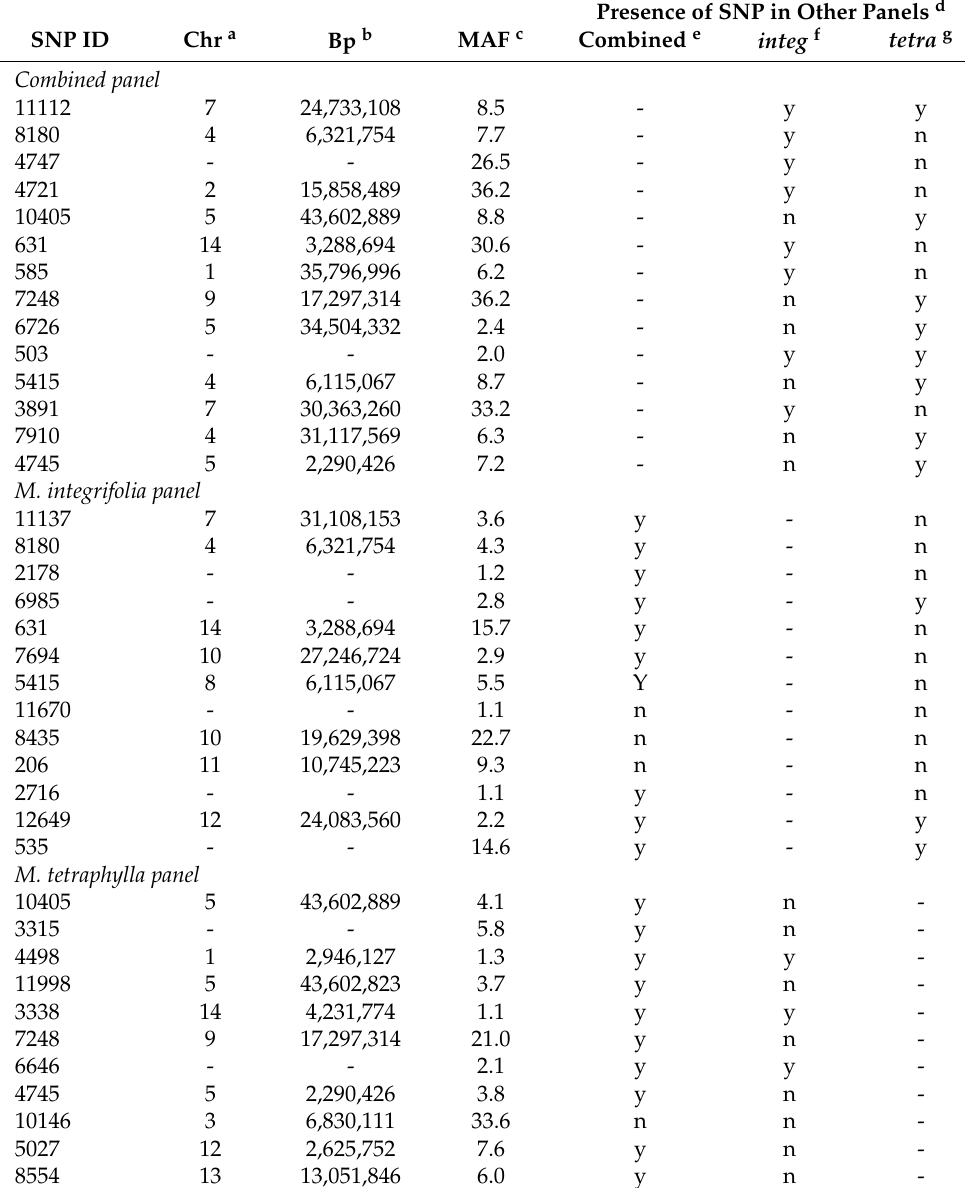
M. integrifolia panel post quality control filtering (Table 6). Table 6. Summary of information relating to SNPs significantly associated with at least one stick- tight trait (STC or STI in 2020 or 2021) at p < 0.001 for either the combined, M. integrifolia , or M. tetraphylla